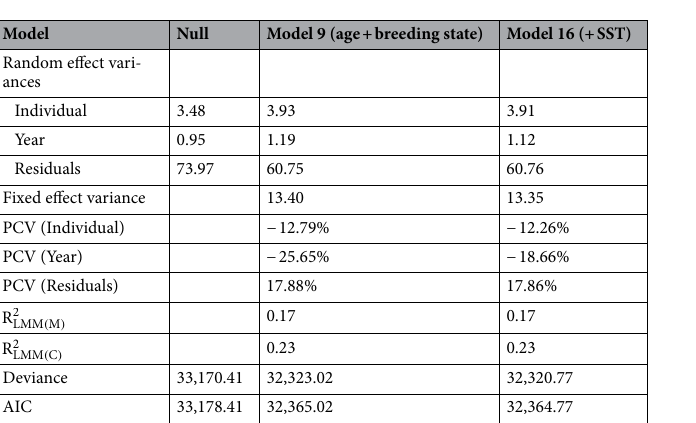
Figure 3. ( a ) Mean moult haulout duration (and 95% confidence intervals) of female southern elephant seals at Marion Island according to age and breeding state. Estimates were obtained from model 9 (Table 3). ( b ) Observed means (black circles) and predicted change (linear regression) in moult haulout duration of female elephant seals with variation in sea surface temperature (SST). The linear regression (with 95% confidence intervals) were obtained from model 16 (Table 3). Individual data points are plotted on both figures (pink— juveniles, green—non-breeding adults and blue—breeding adults).